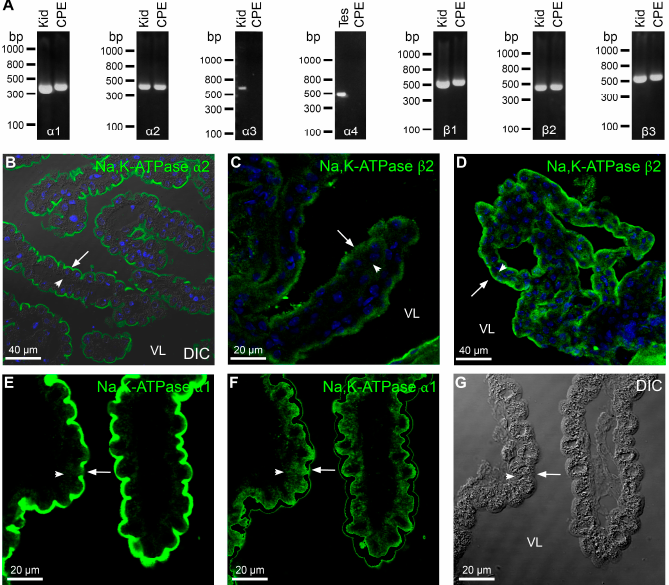
Figure 1. Na,K-ATPase expression in the mouse choroid plexus epithelium (CPE). ( A ) RT-PCR analysis of Na,K-ATPase subunit in fluorescence-activated cell sorting (FACS) isolated CPE cells (CPECs). Intact mouse CP were labelled with concanavalin A-fluorescein from the luminal side. The cells were separated and CPECs enriched by FACS to more than 99.9% purity. After reverse transcription, primers were applied with the cDNA in PCR reactions as indicated on the figure: Na,K-ATPase subunits ( α 1–4, β 1–3). CPE designates FACS isolated CPECs, while Kid and Tes denote the control tissues mouse kidney cortex and mouse testis, respectively. Molecular size is indicated left to the individual gels. ( B ) Immunofluorescence localization of the Na,K-ATPase α 2 subunit to the luminal membrane domain of the CP. ( C , D ) Micrographs of similar labeling patterns with two antibodies against the Na,K-ATPase β 2 subunit. ( E ) Overexposure micrograph of the luminal membrane domain of the Na,K-ATPase α 1 subunit (green). ( F ) The same micrograph after thresholding the most intense pixel values to reveal the subcellular sites of low abundance expression of Na,K-ATPase α 1. ( G ) Corresponding differential interference contrast (DIC) image of the same cells. Arrows indicate luminal surfaces, while arrowheads mark basolateral surfaces. VL denotes the fourth ventricle